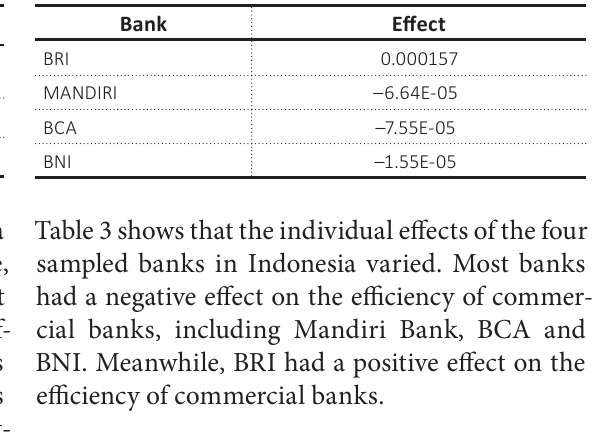
Table 2. Individual significance test results Table 3. Cross sectional fixed effect test results